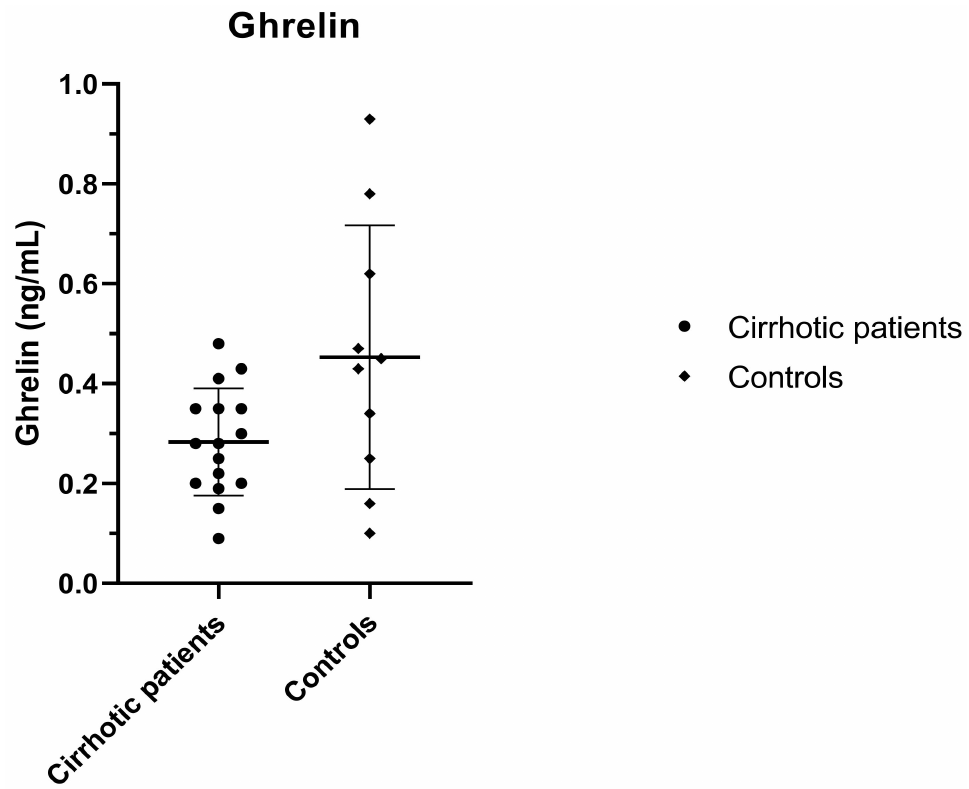
Figure 1. Plasma circulating ghrelin levels (ng/mL) in cirrhotic patients and healthy